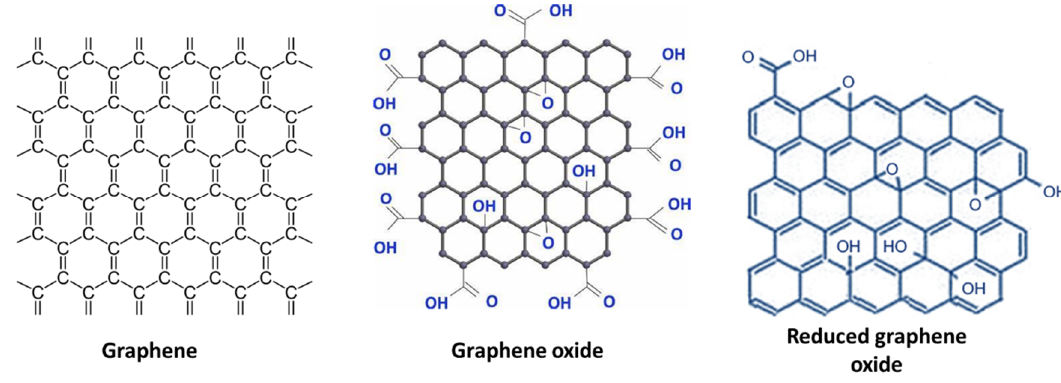
Figure 7. Chemical assembly of GN, GO, and rGO.